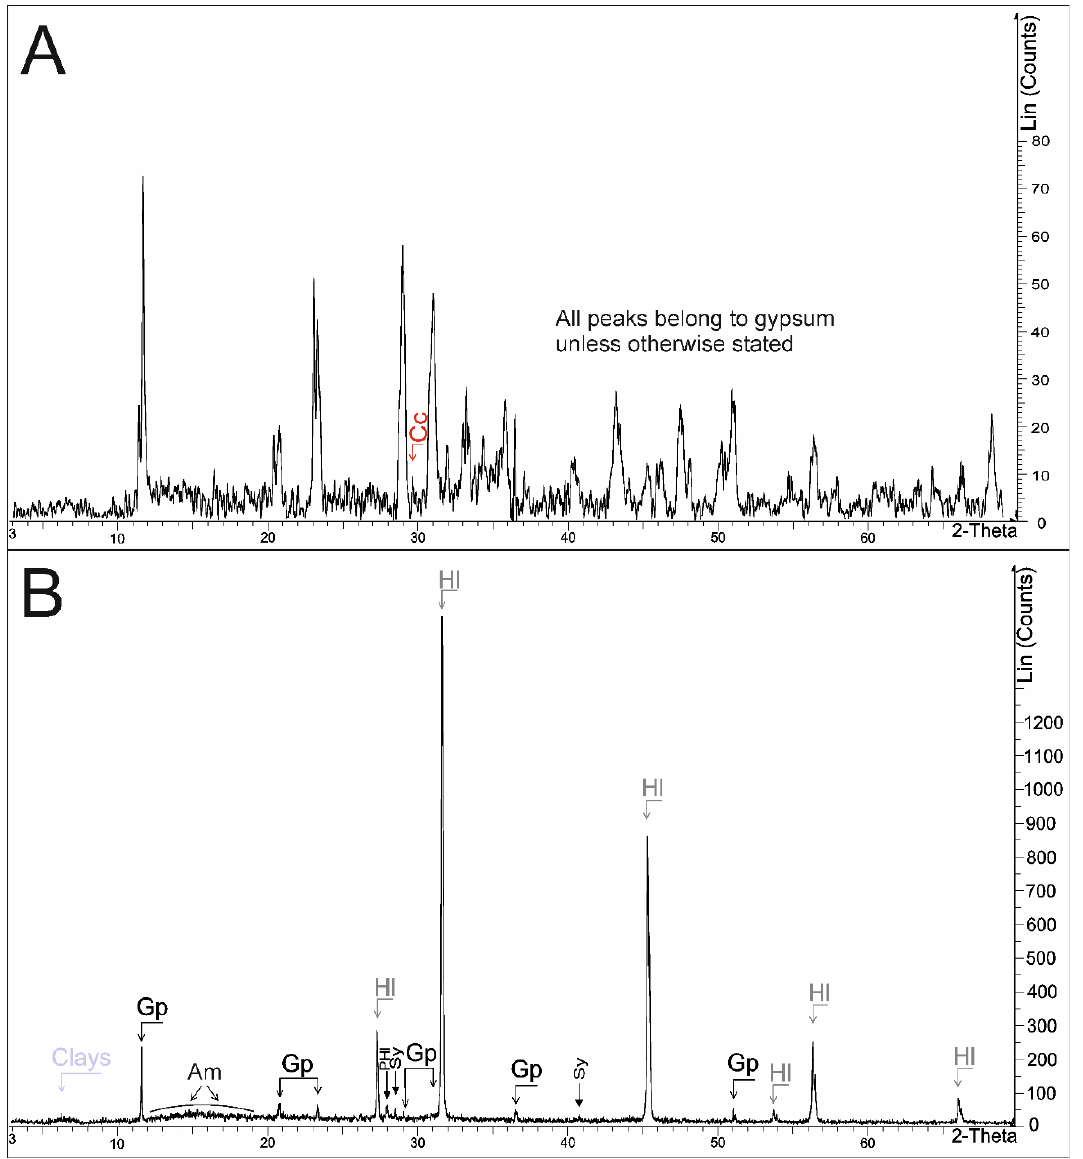
Figure 7. Representative X-ray diffractions of microbial mat samples. ( A ) Semi-quantification of crystalline phases showed 95% gypsum and 5% calcite (Cc) in a Salar de Pajonales microbial mat (PAJ-10). ( B ) A second microbial mat from Salar de Gorbea (GOR-16) showed 49% halite (Hl), 25% gypsum (Gp), 13% polyhalite (PHl), 11% clay minerals, and 2% sylvite (Sy). Am = amorphous phases (not semi-quantified). Reflection peaks surpass 1200 counts in the GOR mat in contrast with PAJ mat, which shows a lower crystallinity. Note that sylvite, polyhalite, and part of the halite present may be a consequence of the sample preparation. These minerals may have precipitated during the dehydration of interstitial brine contained in the